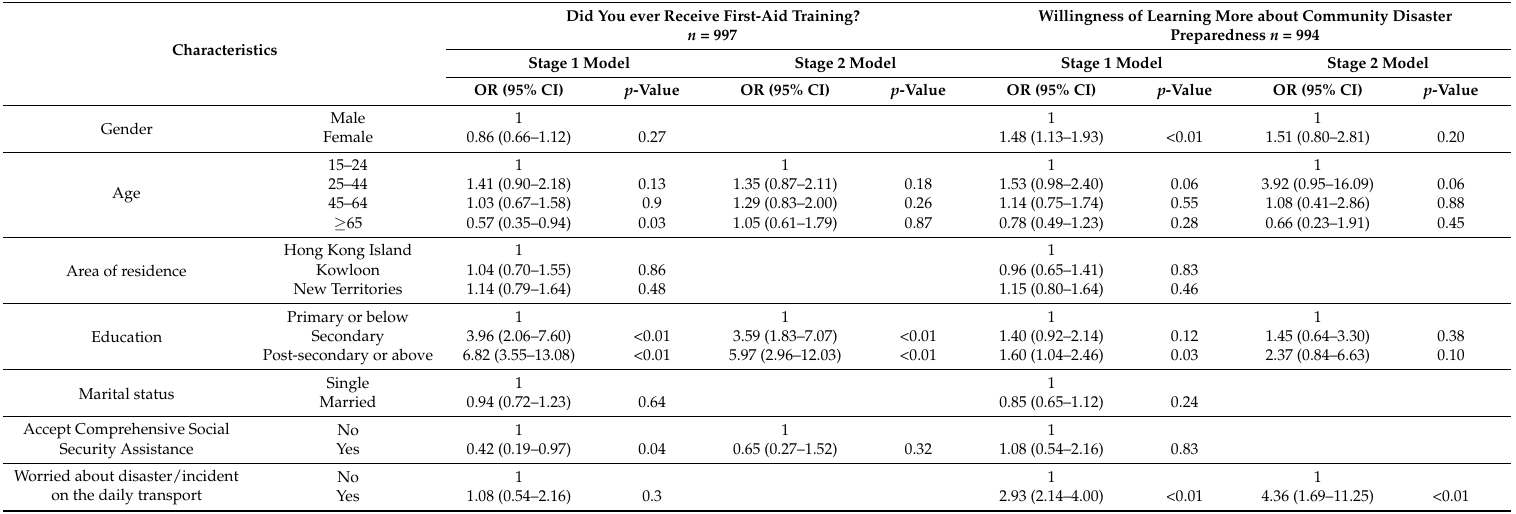
Table 4. Factors associated with receiving first-aid training and willingness of learning more about community disaster